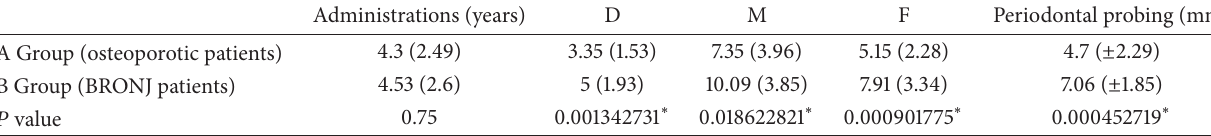
Table 3: A Group versus B Group—evaluation of clinical and statistical significance.